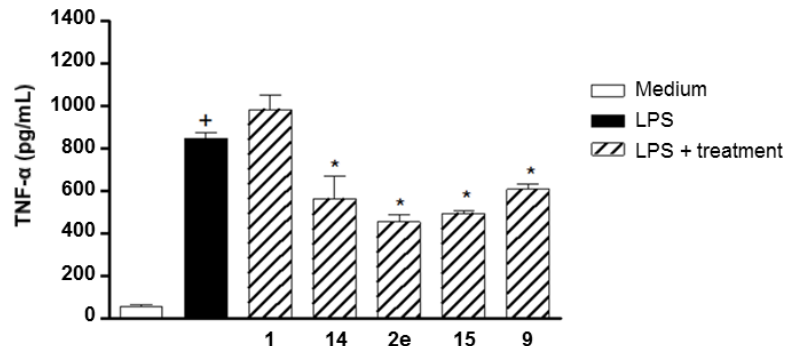
Figure 2. Effect of the phthalimide phenyl sulfonamide derivatives 1 and 2e , the carboxyamide phenyl sulfonamide derivatives 14 and 15 , and the standard thalidomide ( 9